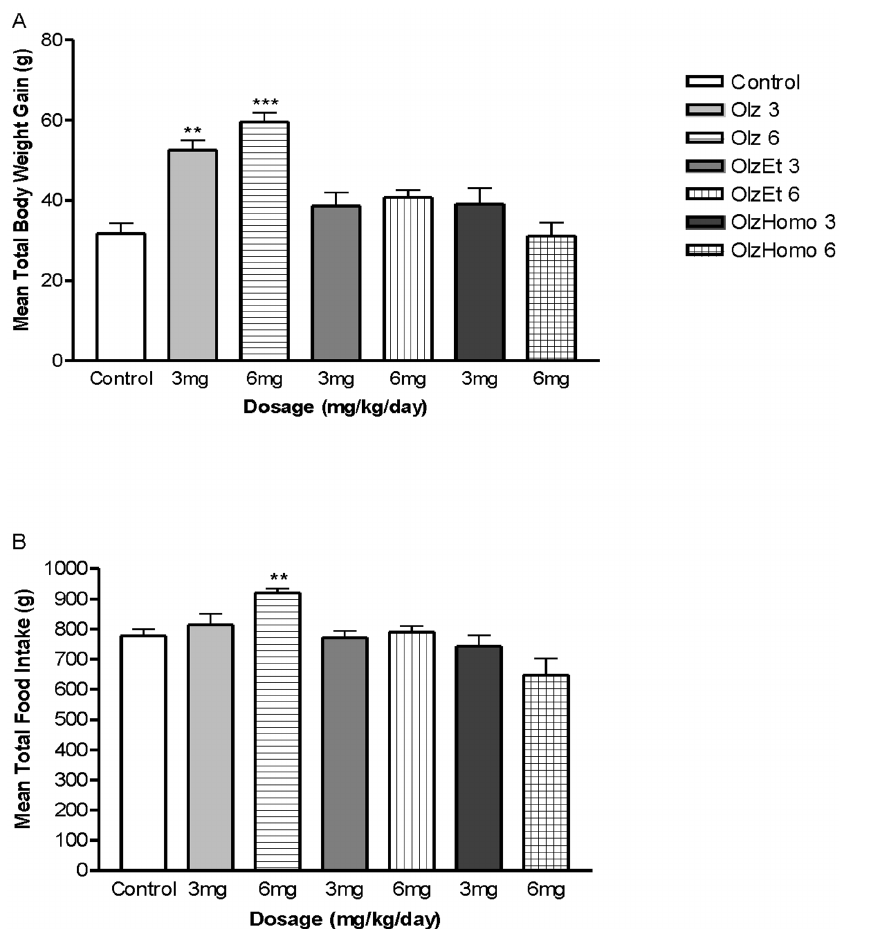
Figure 1. Total weight gain and food intake in female rats treated with Olz and Olz derivatives. A. Total body weight gain (g), B. Total food intake (g) in female Sprague Dawley rats treated with Olz, OlzEt, OlzHomo (3 mg/kg or 6 mg/kg), or vehicle (Control) for 5 weeks. The data points are the mean 6 SEM, ** P , 0.01 and *** P , 0.001 vs . Control.